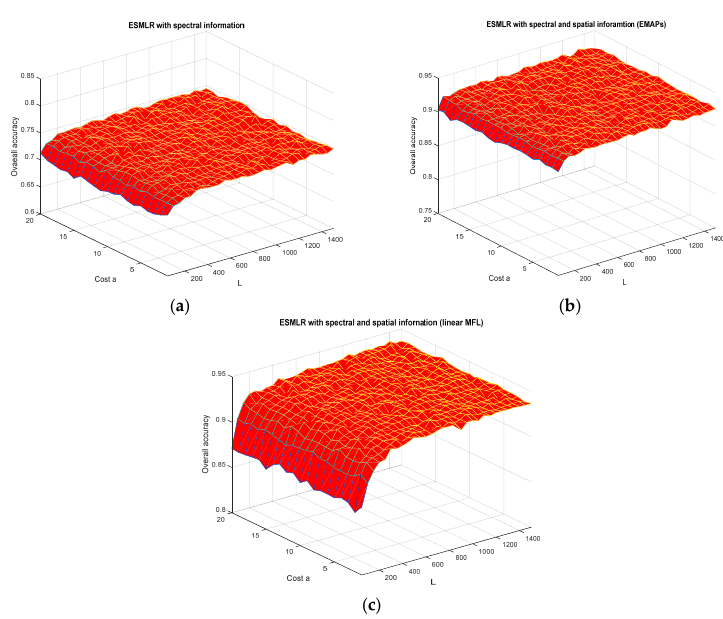
Figure 2. The robustness performance of the proposed framework based on the Indian Pines dataset: ( a ) The proposed ESMLR with spectral information (200 features and b = − 7); ( b ) The proposed ESMLR with spectral and spatial information (EMAPSs) (36 features and b = − 11); ( c ) The proposed ESMLR with spectral and spatial information (proposed linear MFL) (236 features and b = − 10).